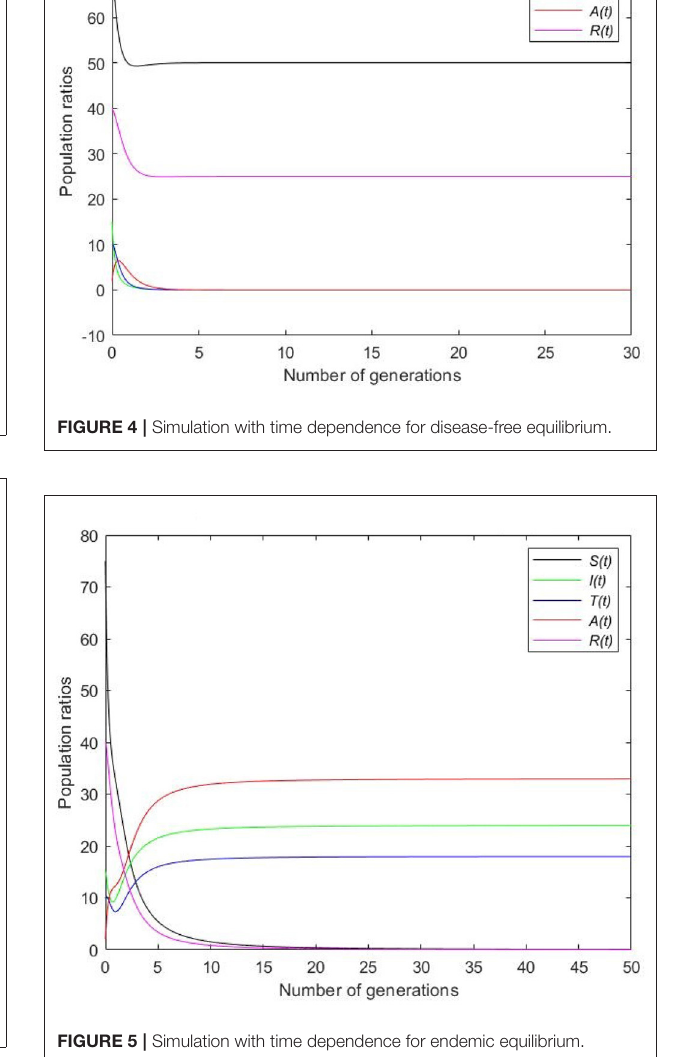
FIGURE 5 | Simulation with time dependence for endemic